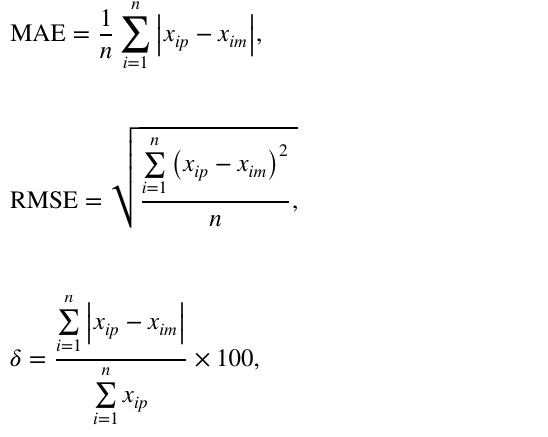
Table 2 Selection of the more appropriate kernel function